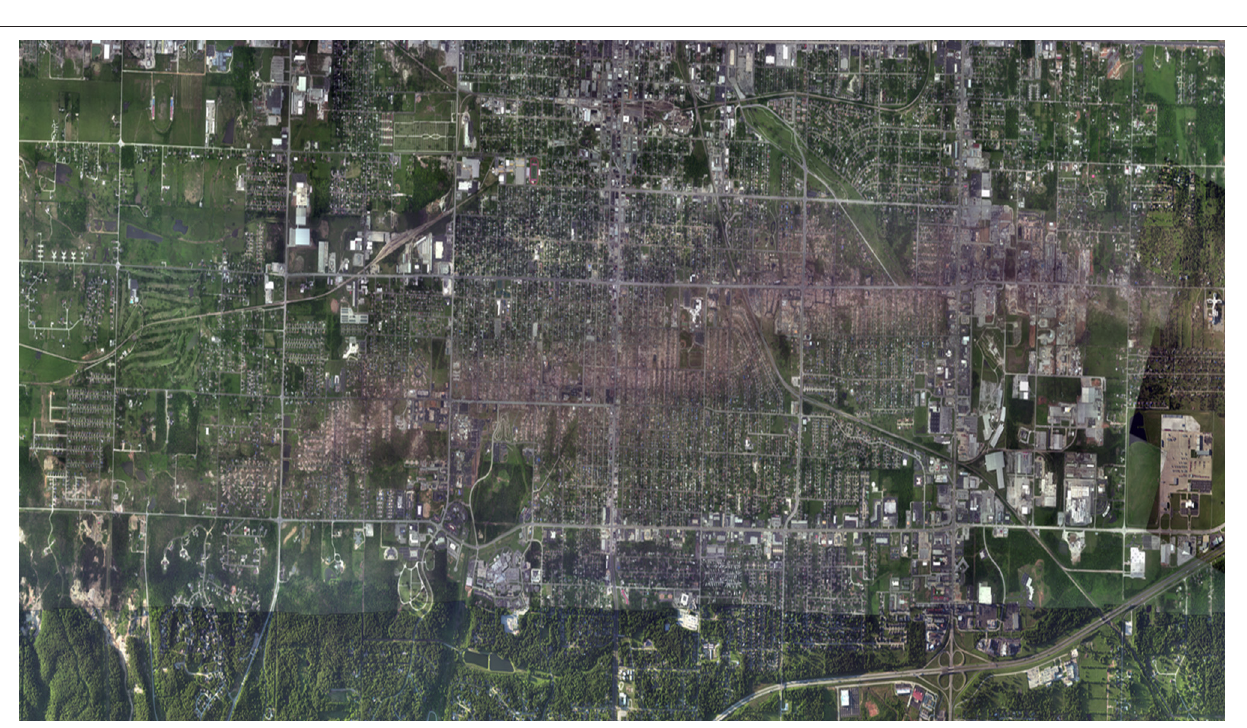
neighborhood-level aerial imagery acquired by NOAA alongside pre-event imagery for a neighborhood affected by the 2011 Tuscaloosa, AL,